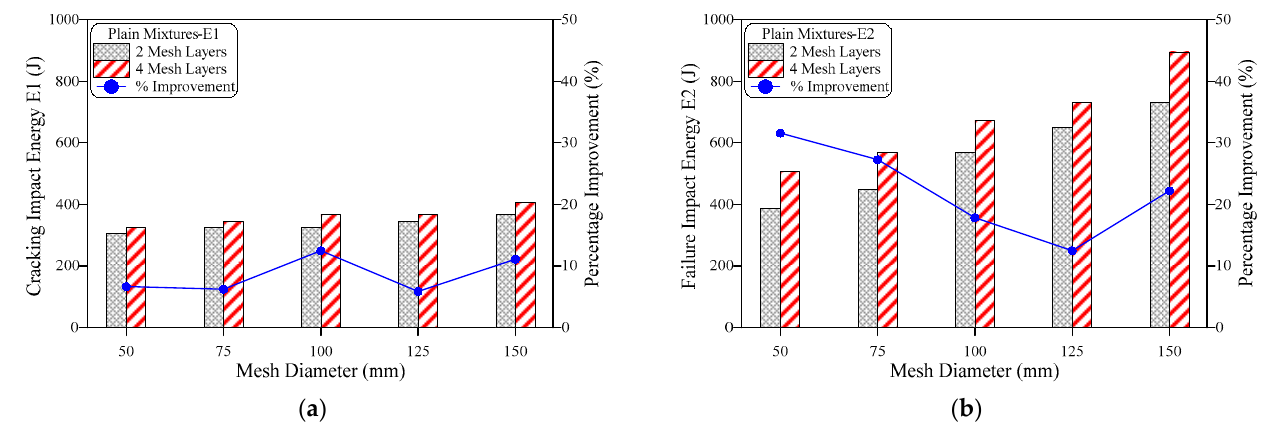
Figure 6. Effect of number of mesh layers on the impact energy of plain mixtures, ( a ) cracking energy E1, ( b ) failure energy E2.